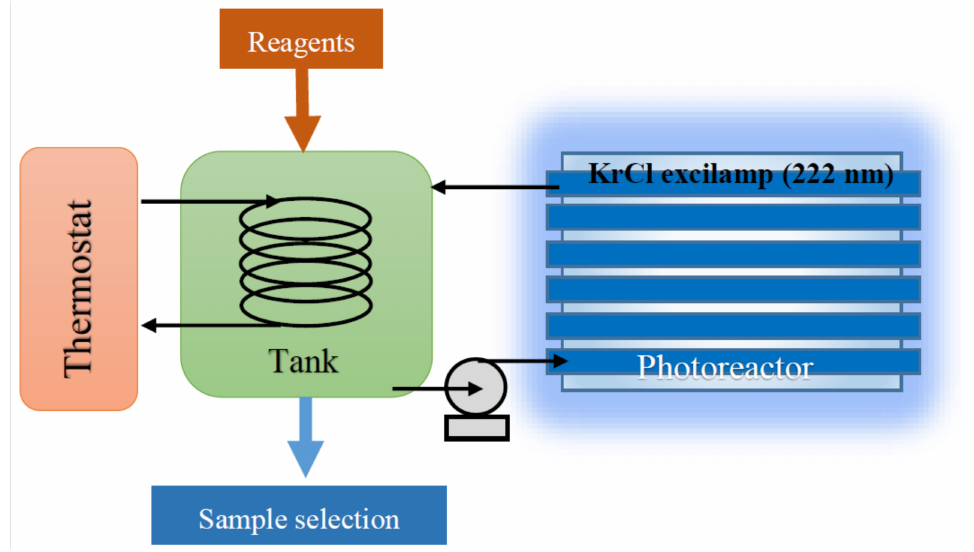
Figure 1. Schematic representation of the experimental